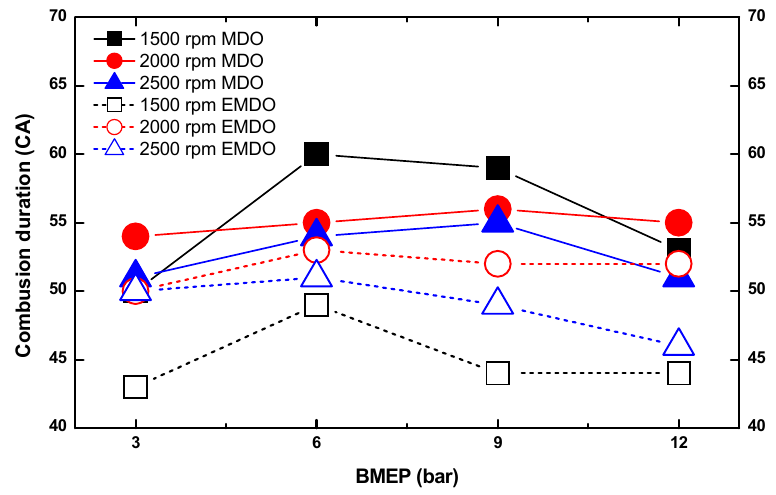
Figure 5. Characteristics of the combustion duration according to brake mean effective pressure (BMEP) and rpm.